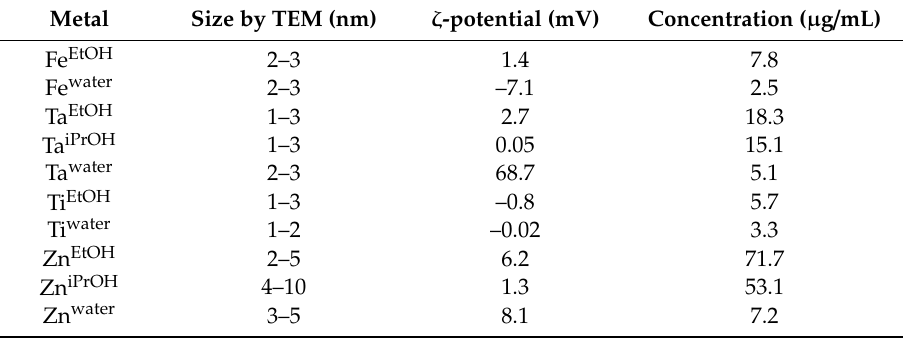
Table 1. Size and ζ -potential of metal nanoparticles obtained in the media of ethanol, isopropanol and water. Some TEM images are presented on Supplementary Figures S1 and